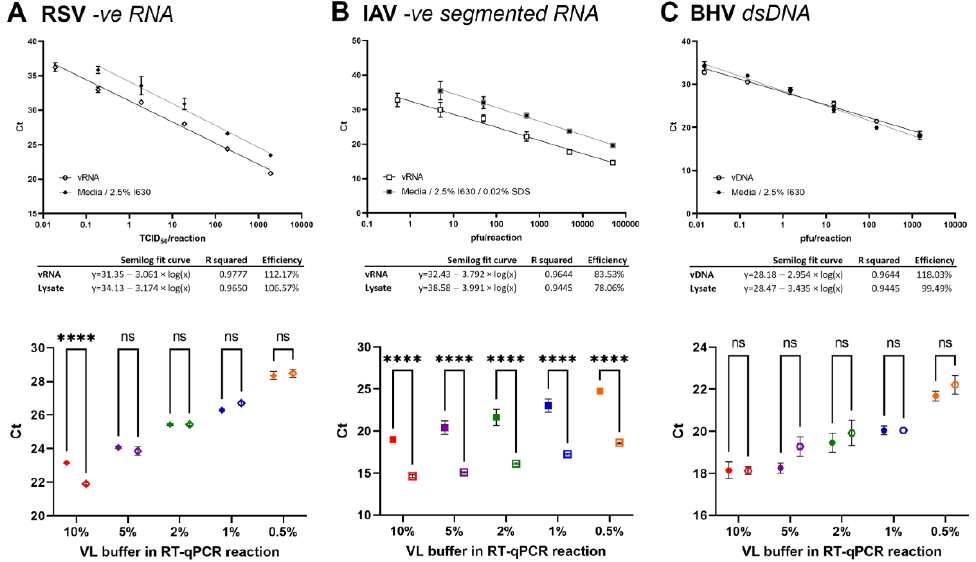
Figure 3. Direct lysis RT-qPCR of other viruses. ( A ) RSV, ( B ) IAV, ( C ) BHV. Top: Serial dilutions of VPM in media lysed in 2.5% IGEPAL-630 lysis buffer and analyzed as described above. n = 3 × 2 ± SEM. Bottom: Decreasing amounts of VPM lysate were added to the RT-qPCR reaction, corresponding to 0.5 – 10% of the reaction volume (as indicated for each curve). Corresponding amounts of vRNA in NF-H2O were run in parallel. n = 3 × 2 ± SEM. Analysis using a 2-way ANOVA. **** p < 0.0001.